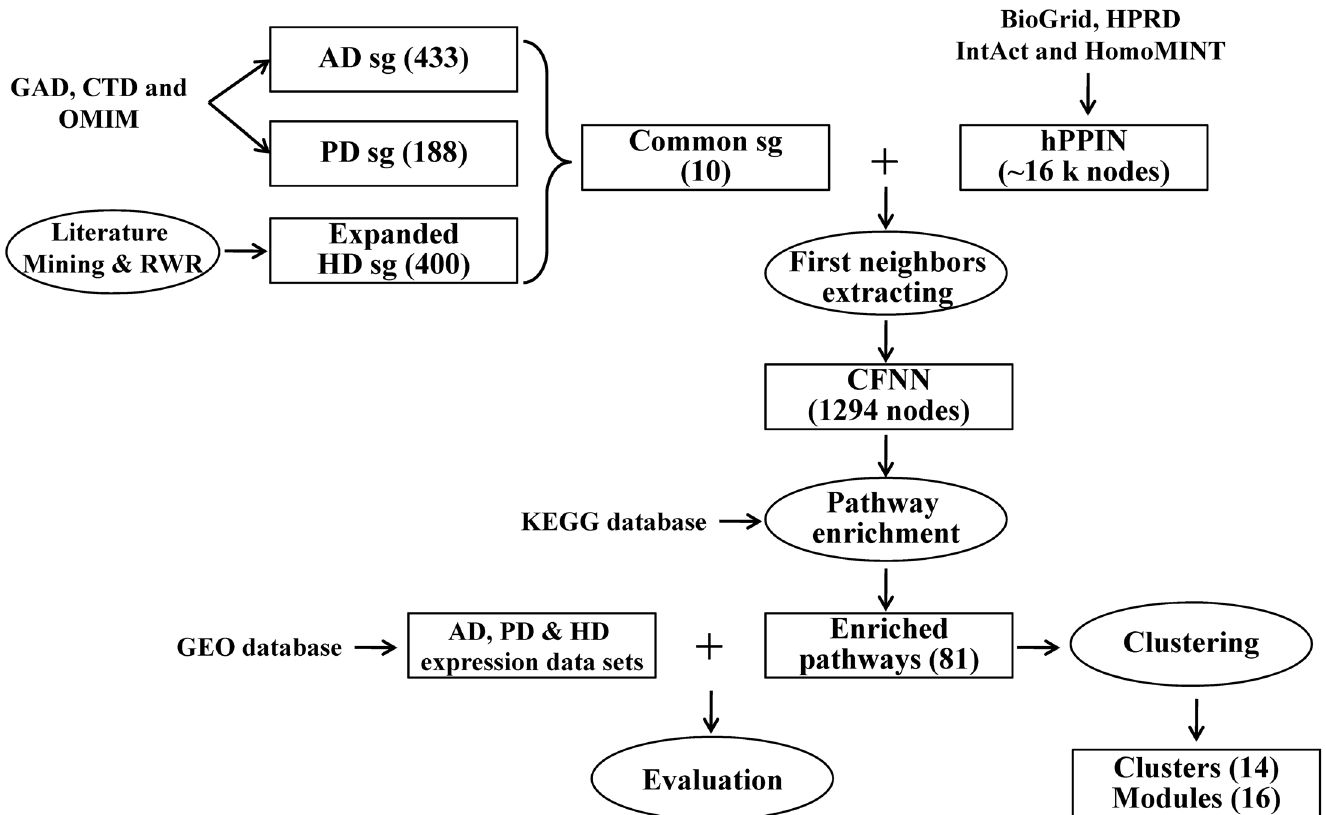
Fig 1. Workflow for identification of shared pathways and common modules among AD, PD and HD. In the first step, AD, PD and HD susceptibility gene (sg) sets were collected and their intersection were defined as common sg. Meanwhile, common sg's first neighbors in the human protein-protein interaction network (hPPIN) was extracted to construct common gene first neighbor network (CFNN). Then, KEGG pathway enrichment analysis was applied to the nodes in CFNN to get shared pathways of AD, PD and HD, following by gene expression analysis to evaluate the found pathways. Finally, hierarchal clustering was applied to cluster the enriched pathways and indentify common modules in CFNN. RWR: random walk with restart.